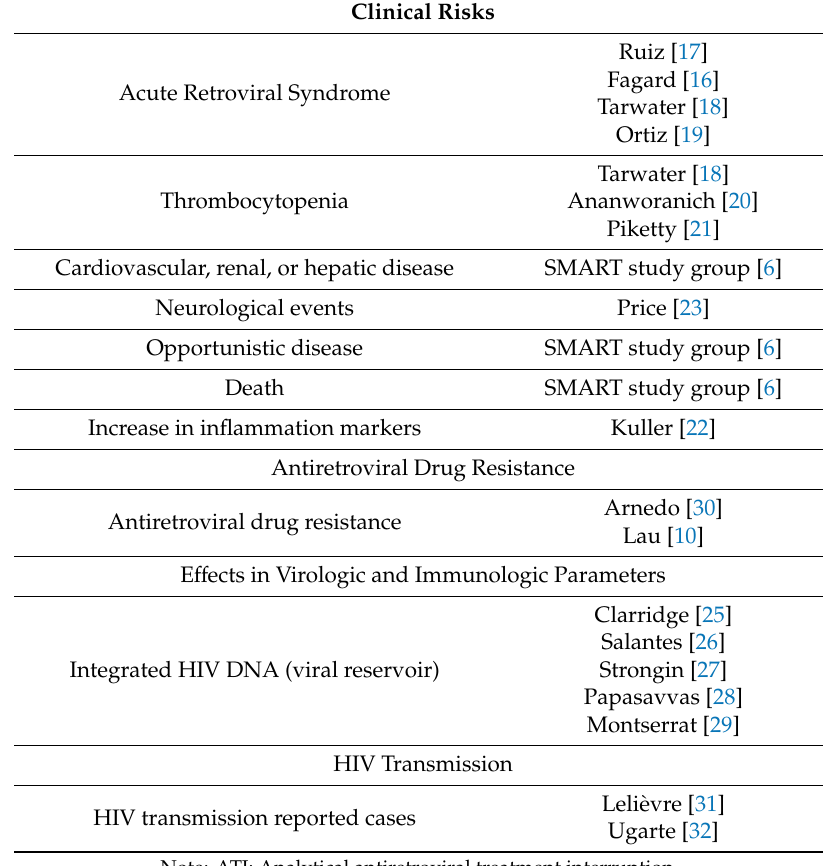
Table 1. Summary of potential adverse e ff ects analyzed and reported in ATI